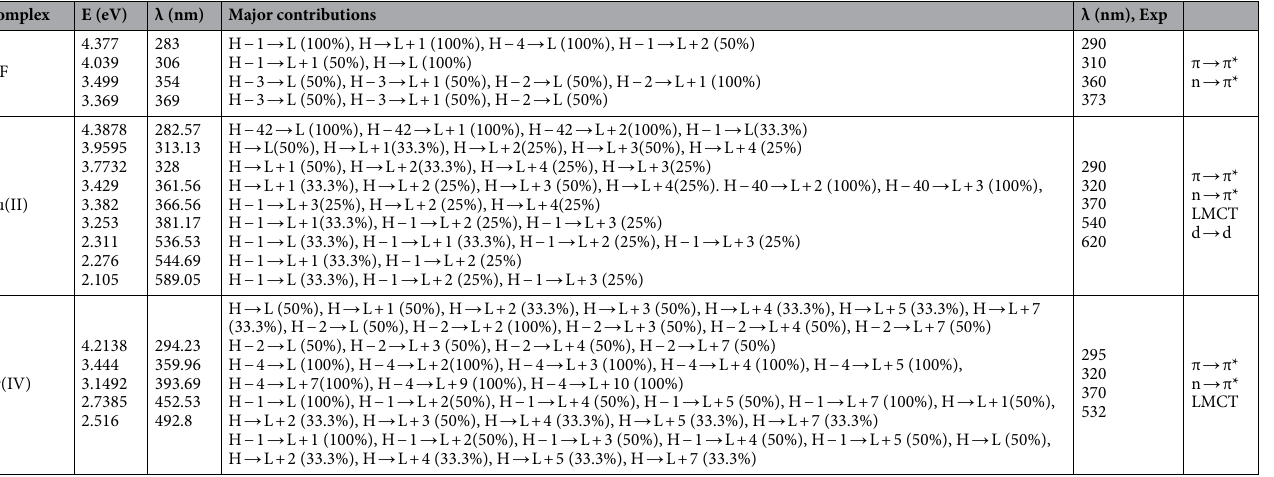
Table 4. Computed excitation energies (au), electronic transition configurations and wave lengths (nm) of the free ligand (MF) and their all obtained stable complexes by using B3LYP/Cep-31G for the, (f ≥ 0.001) f = oscillator strengths.